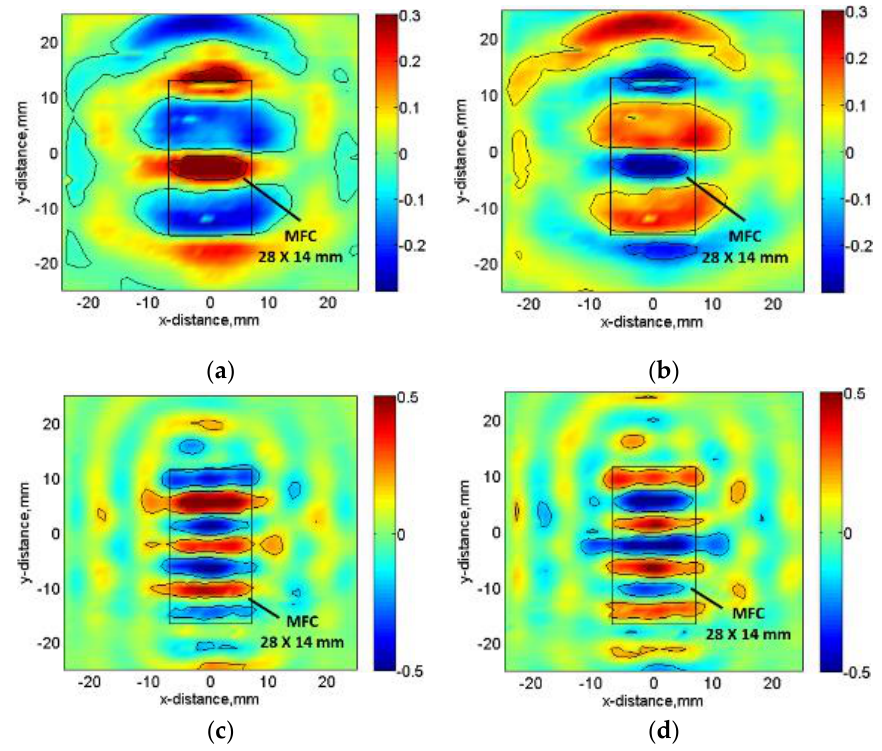
Figure 8. C-scan showing the wave patterns for the A0 mode: at 33 µs ( a ) and 40 µs ( b ) in the case of 80 kHz excitation; at 18.9 µs ( c ) and 21. 6 µs ( d ) in the case of 220 kHz excitation.